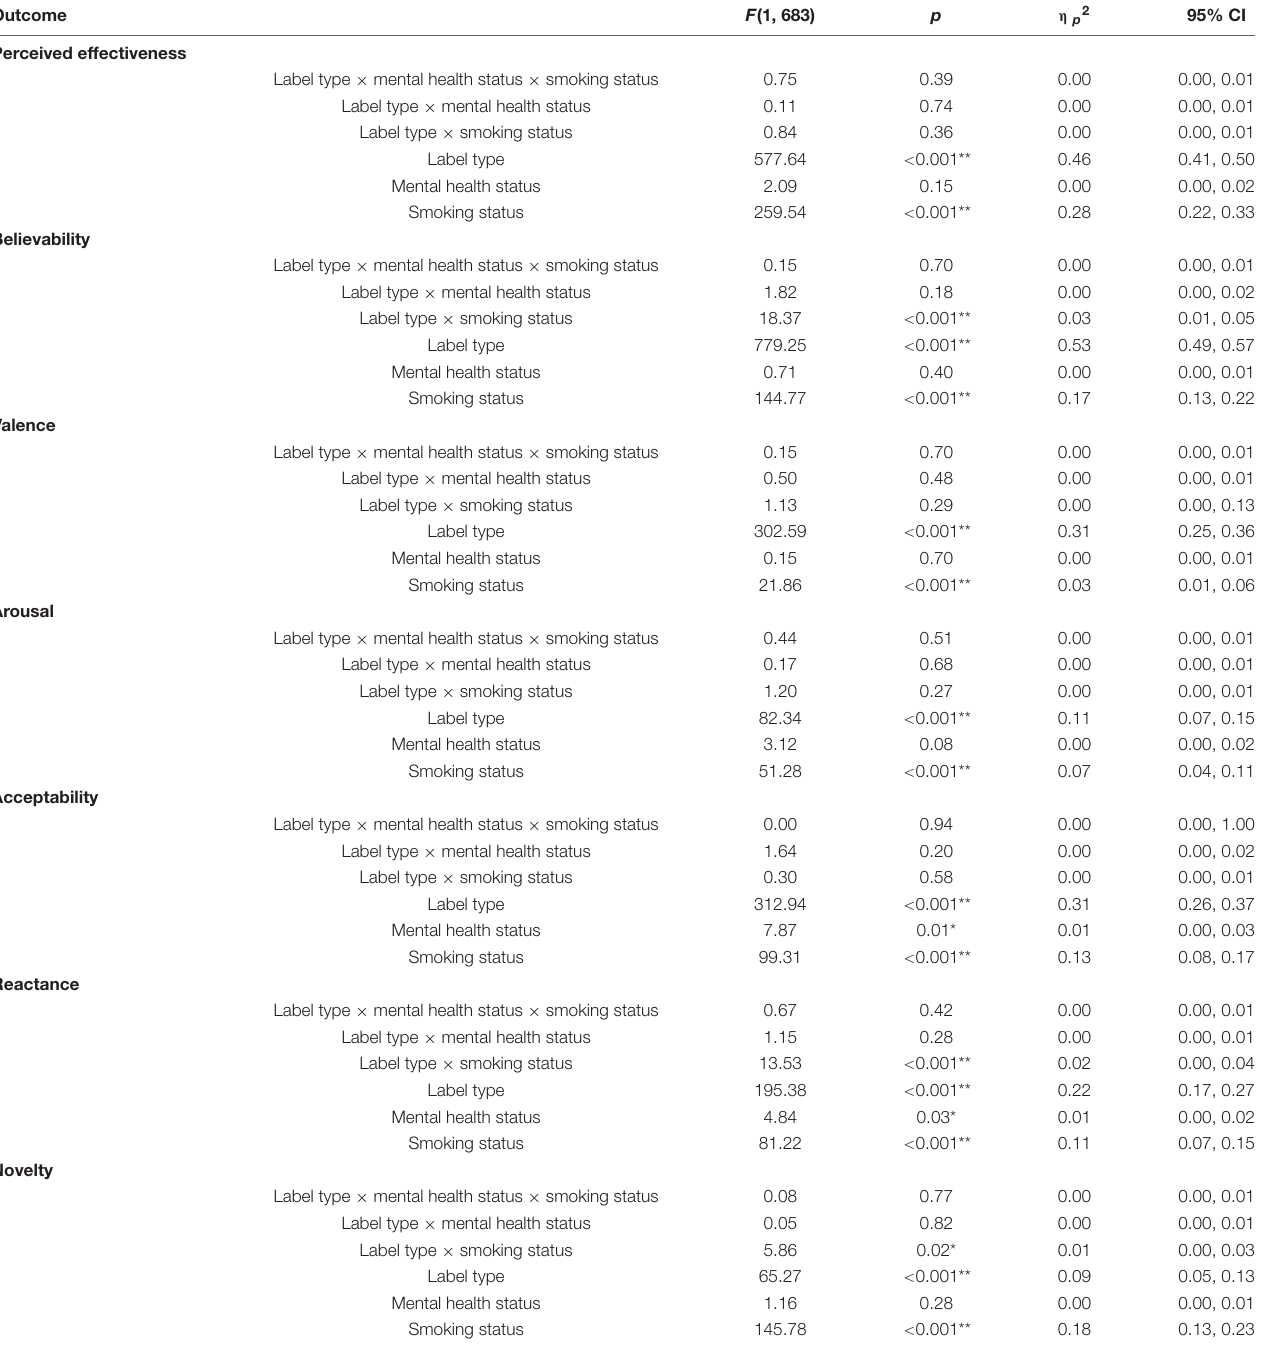
TABLE 3 | Results of mixed ANOVAs for each outcome. Outcome Perceived effectiveness